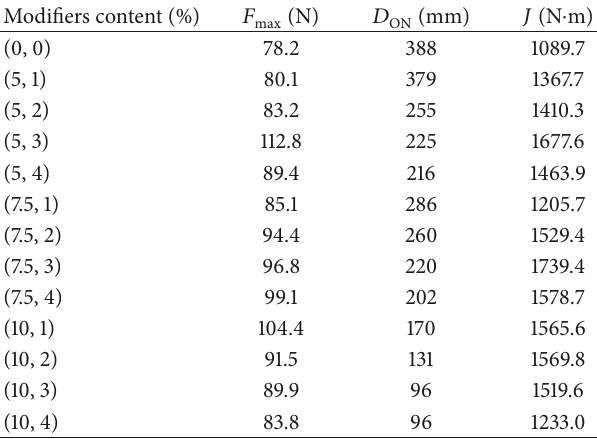
Table 6: Results of force ductility